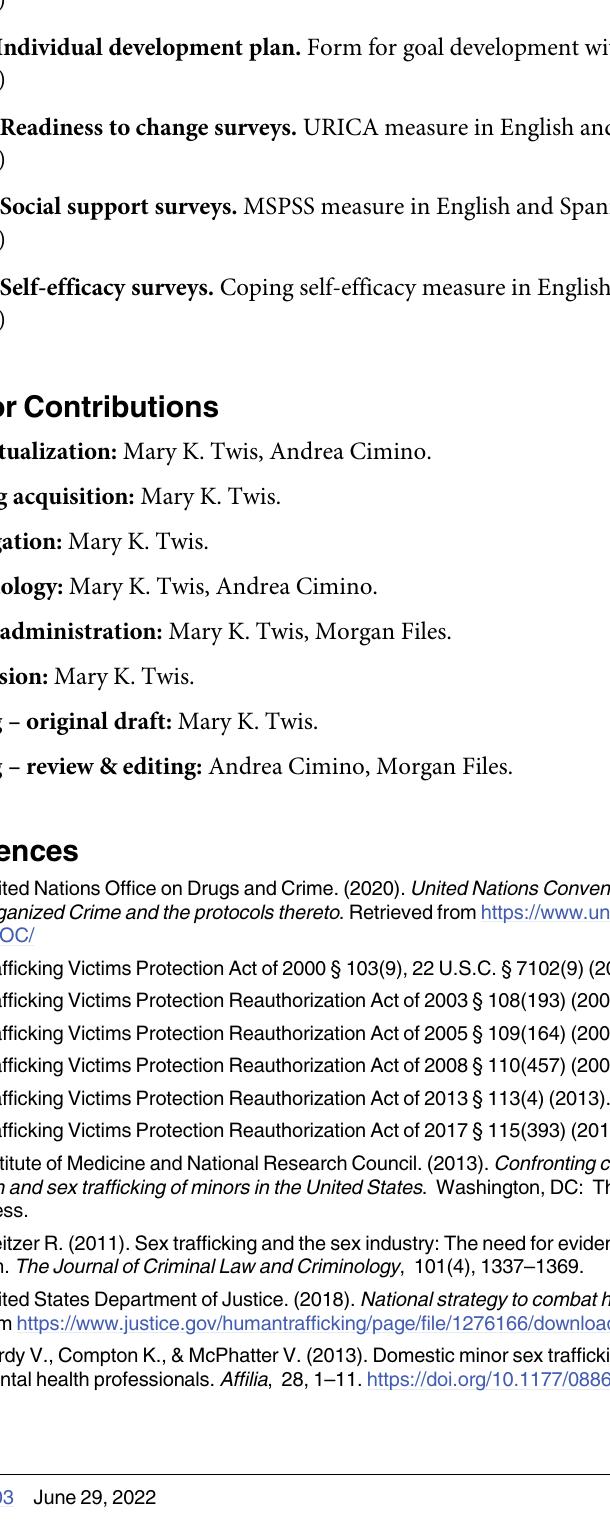
S1 Fig. Case note form. Screenshot of the case note interface form in Apricot. S2 Fig. Individual development plan. Form for goal development with